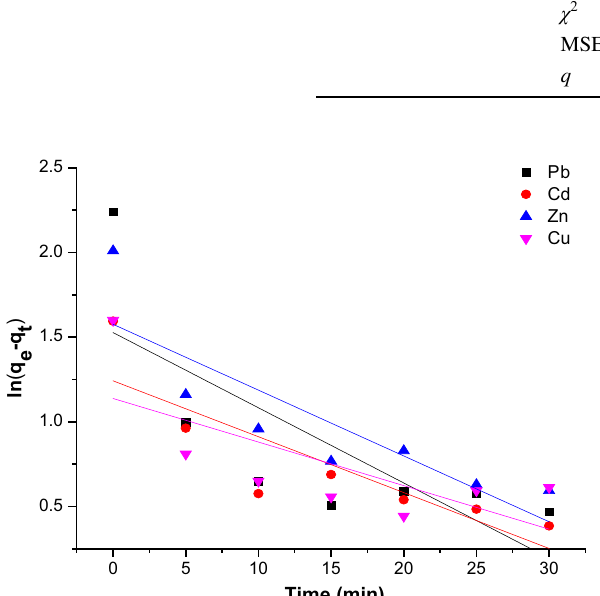
Fig. 14 Pseudo-first-order plots for Pb(II), Cd(II), Zn(II) and Cu(II) ion removal at different times